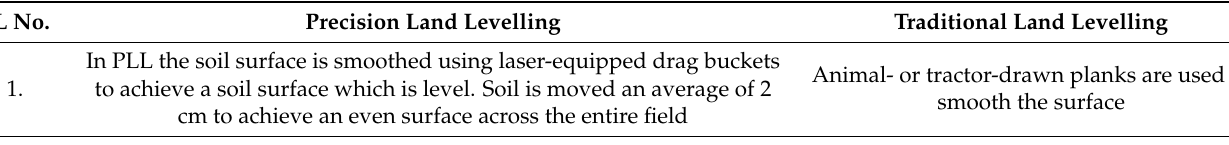
Table 9. Comparison between precision land levelling (PLL) and traditional land levelling